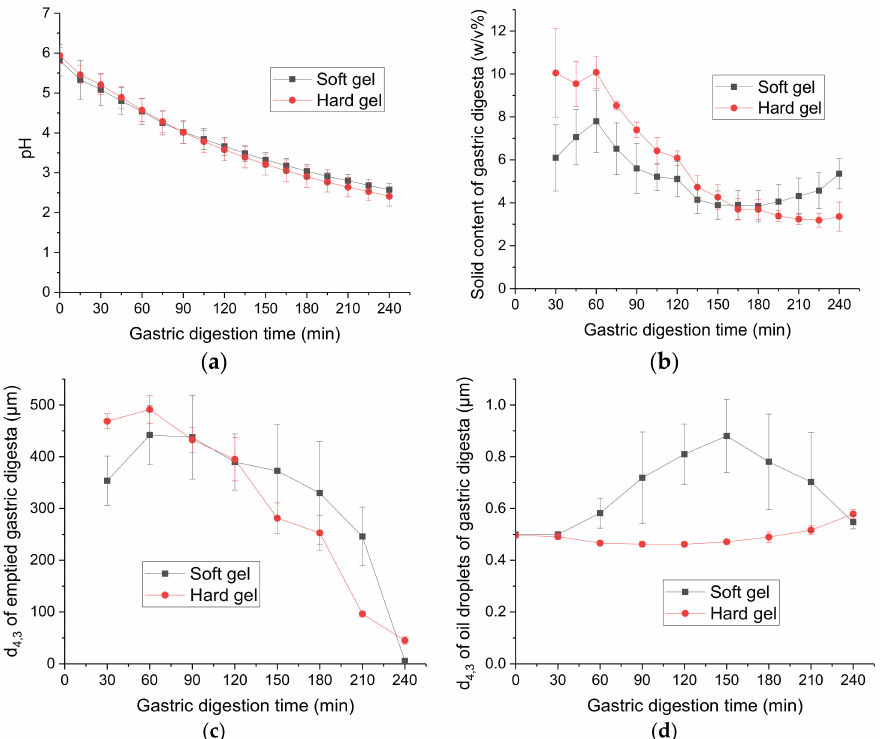
Figure 1. Physicochemical characteristics of the emptied gastric digesta of capsaicinoids (CAP)- loaded whey protein emulsion gels as a function of the digestion time: ( a ) pH; ( b ) solid content; ( c ) average particle size; ( d ) particle size of the oil droplets. Error bars represent standard deviations obtained from three